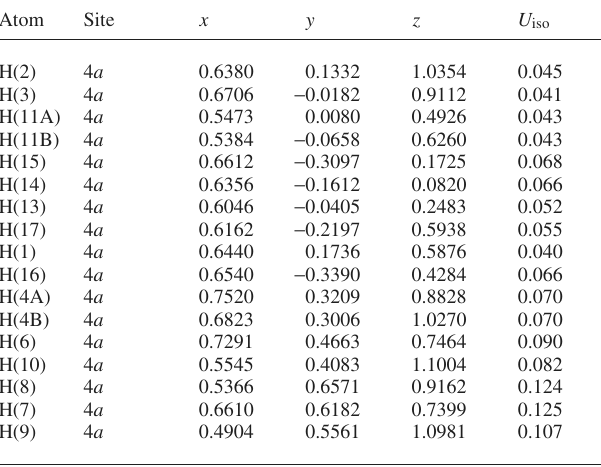
Table 2. Atomic coordinates and displacement parameters (in Å 2 )